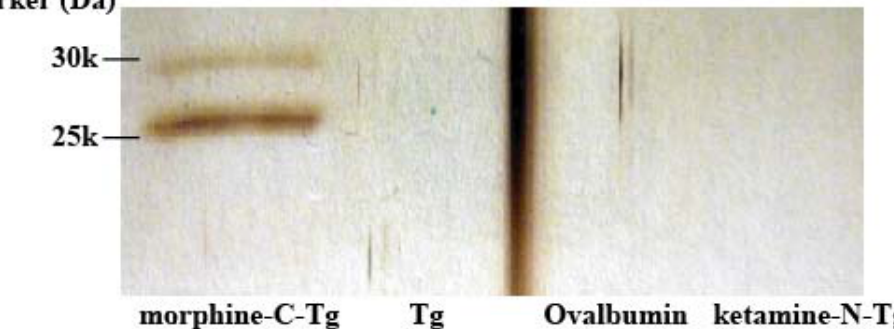
Figure 5. Morphine-binding activity of affinity-purified M86. Affinity-purified M86 with HisTrap HP column (1 µg/0.5 mL) was incubated in an immunotube coated with morphine-C-Tg, Tg, Ovalbumin, or ketamine-N-Tg (2 µg/0.5 mL) as described